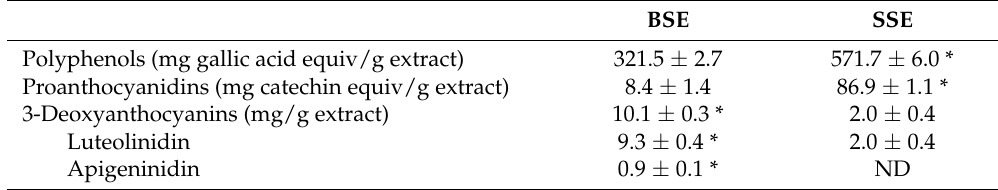
Table 2. Major polyphenol profile of black and sumac sorghum bran extracts.